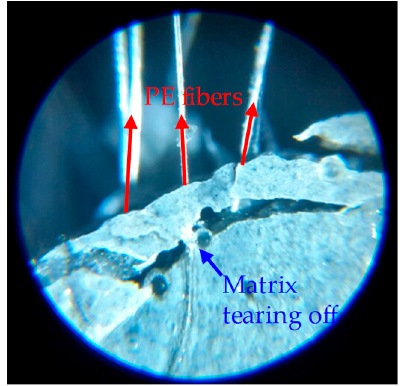
Figure 9. Matrix tearing off phenomenon of PE fibers in UHPCCs.